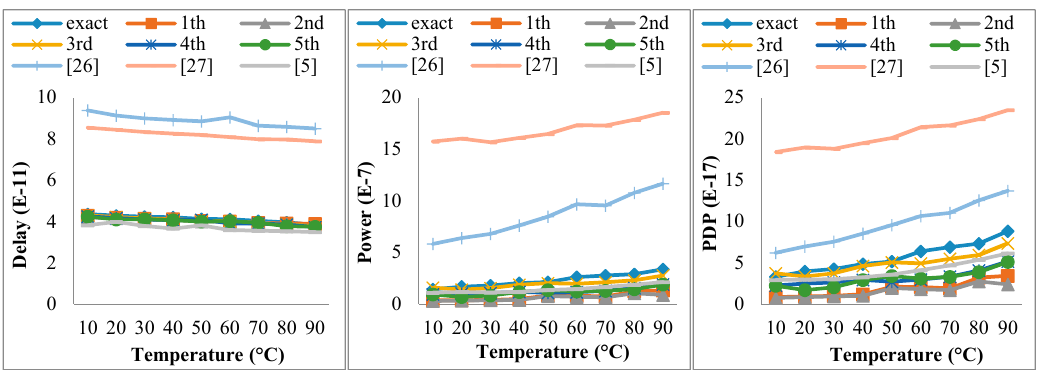
Figure 8. Operation of the proposed methods under temperature variation.